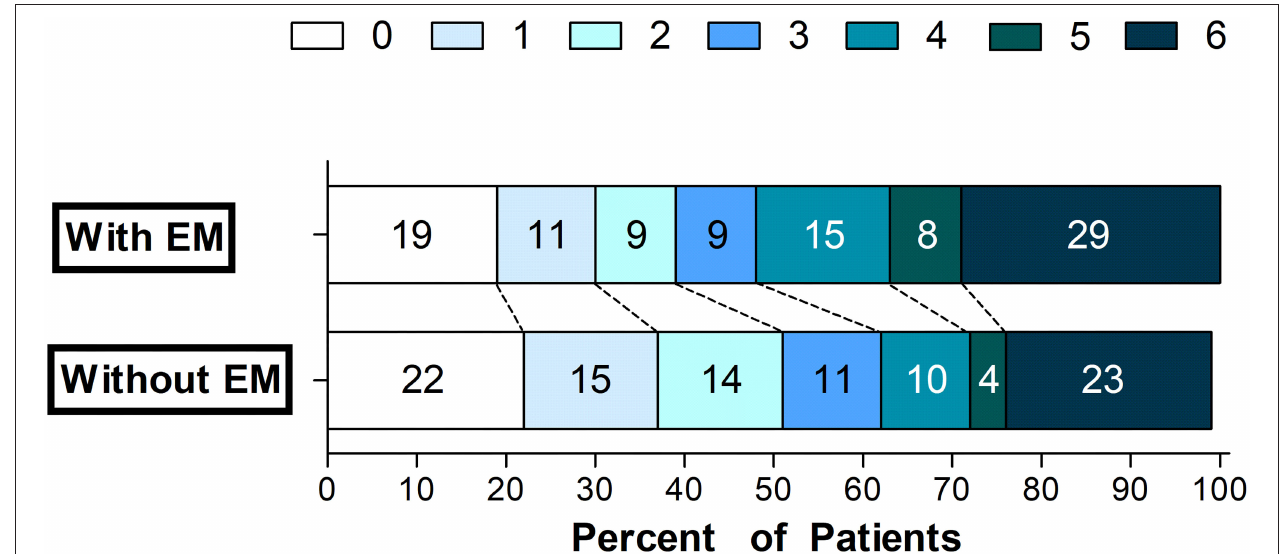
FIGURE 2 | Scores on the mRS grouped by the presence of a pre-existing encephalomalacia. EM, encephalomalacia; and mRS, modified Rankin Scale.